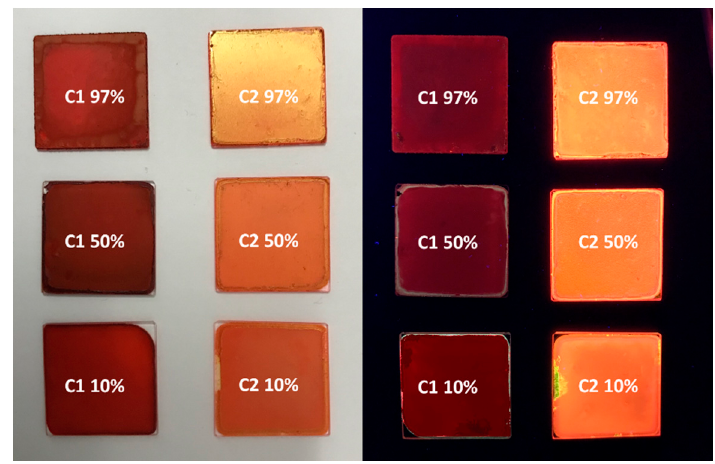
Figure 3. Samples of C1 and C2 deposed on quartz slides at different dopant percentages in natural ( left column) and under 375 nm UV light ( right column). Table 2. Optical data recorded on solid samples.